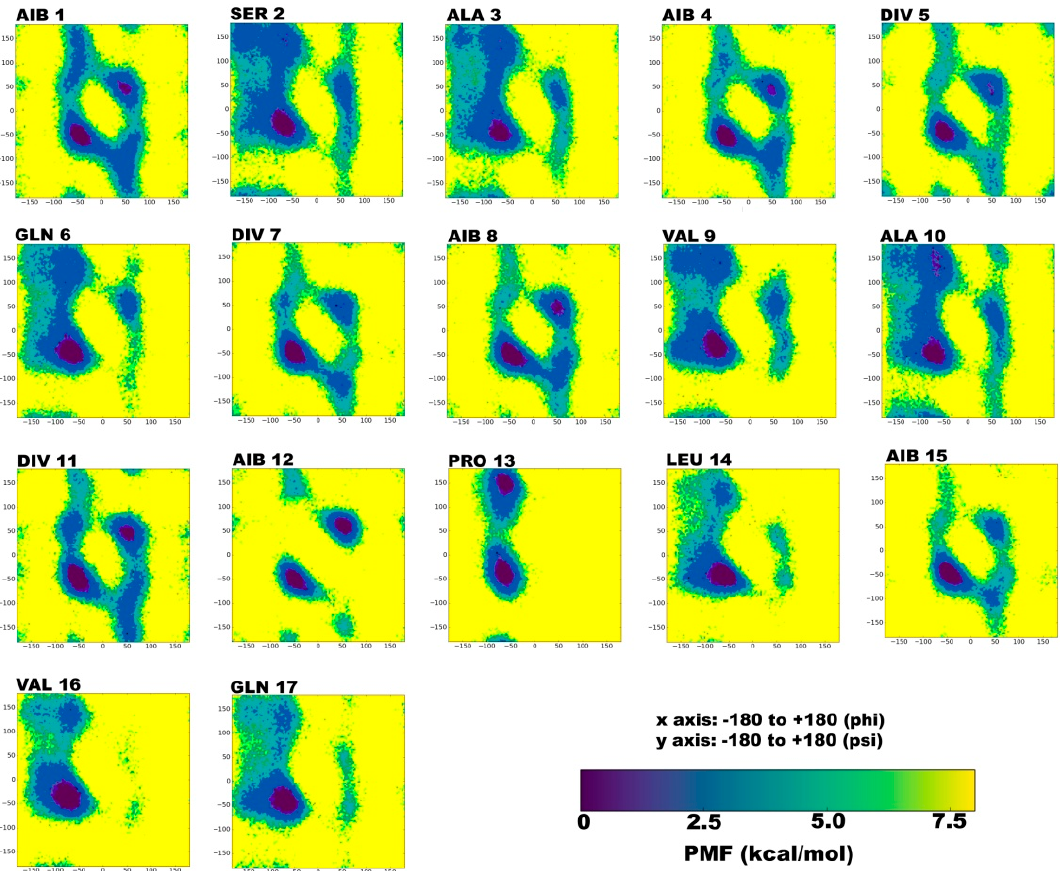
Figure 1. Reweighted PMF (potential of mean force) phi-psi dihedral angle plots for each TPN XIIc residue during explicit water aMD simulation. The x and y axes range from -180 to +180. The darkest violet regions indicate toward minimum energy secondary structural regions favored by each residue during the simulation.